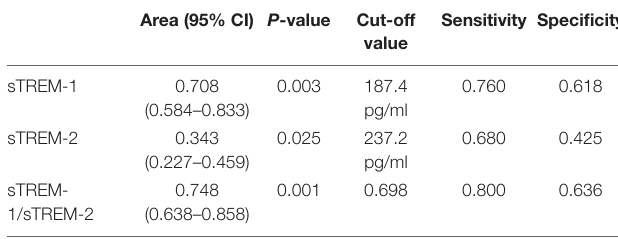
TABLE 3 | Area under the receiver operating characteristic curves for serum levels of sTREM-1 and sTREM-2 on day 1 for the prediction of SARs.